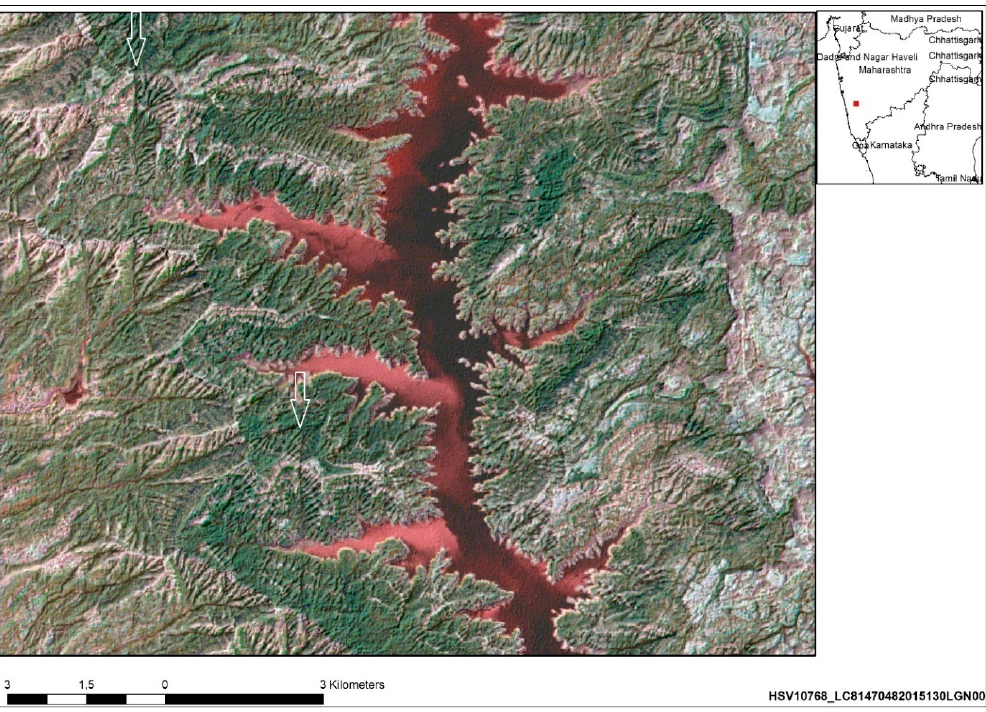
Figure 10. Landsat 8 thermal bands (10, 7, 6, merged with band 8) RGB-combination enhancing NS- and NE-SW-oriented linear features (arrows).